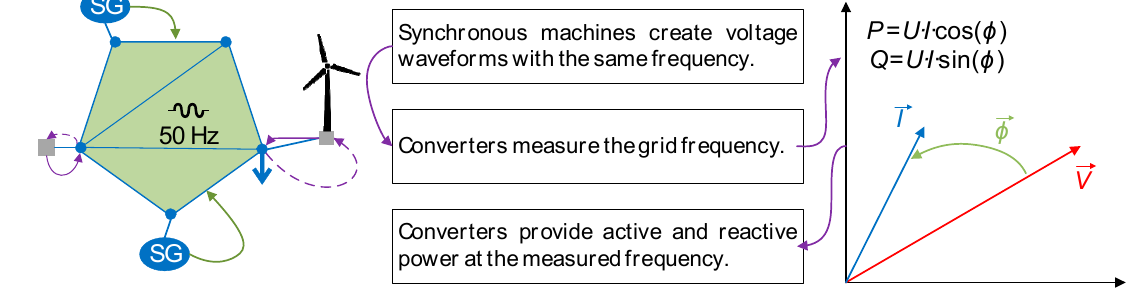
Figure 1. Operational concept of conventional grid-following converters